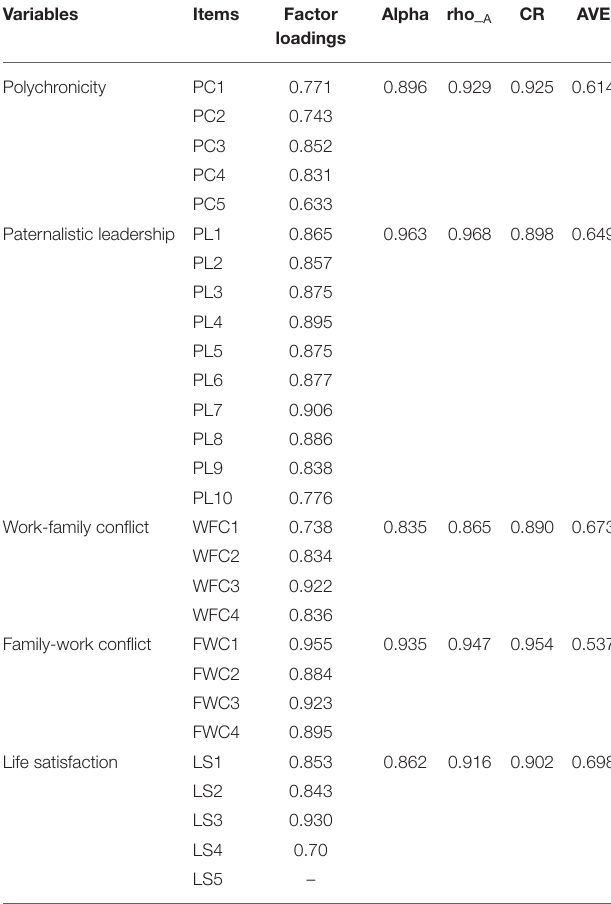
average-variance-extracted.